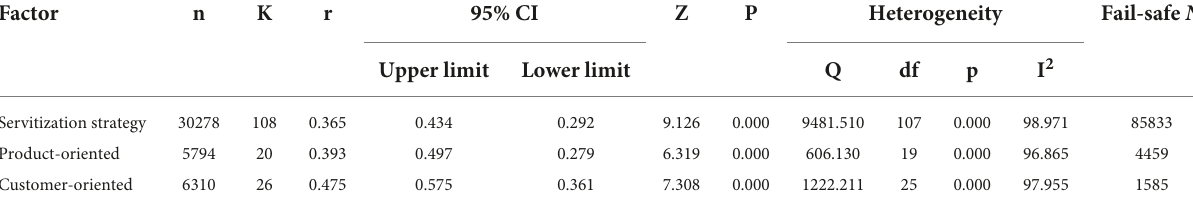
TABLE 2 Overall effect test.